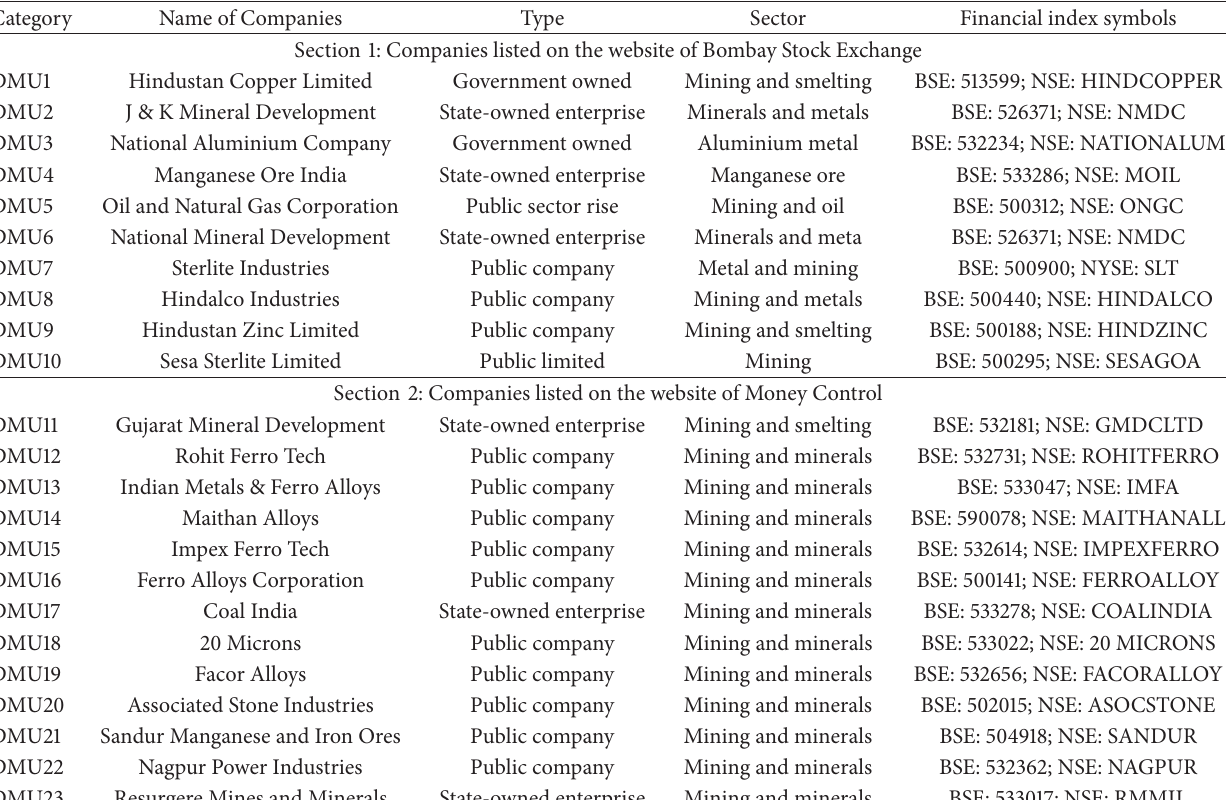
Table 1: List of mining companies of India.